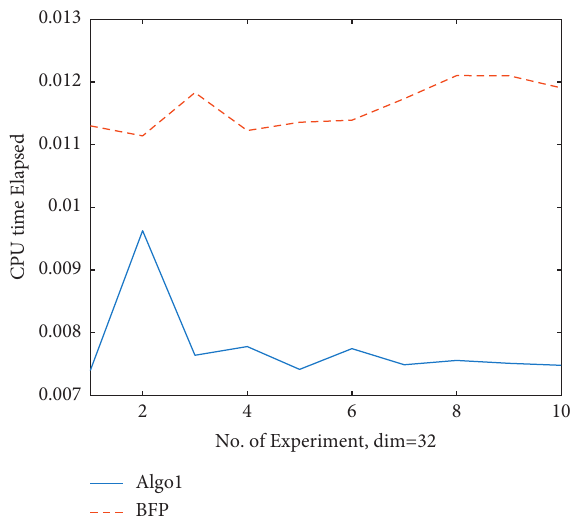
Figure 20: CPU time vs no. of iteration for dimension 32.